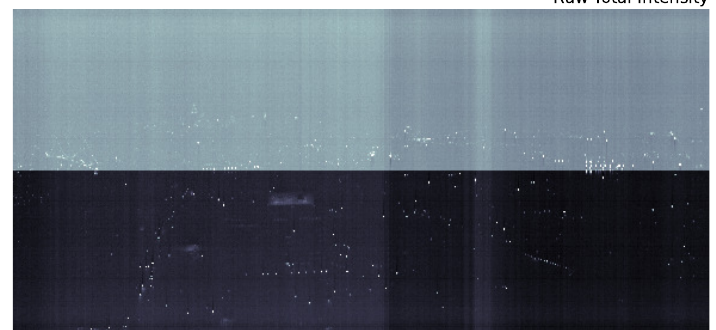
Figure 3. Raw data from the scan in Figure 2 integrated across the full 0.4–1.0- µ m range. Artifacts due to chip offsets between the upper and lower half of the CCD, as well as gain changes during the scan (vertical stripes) are